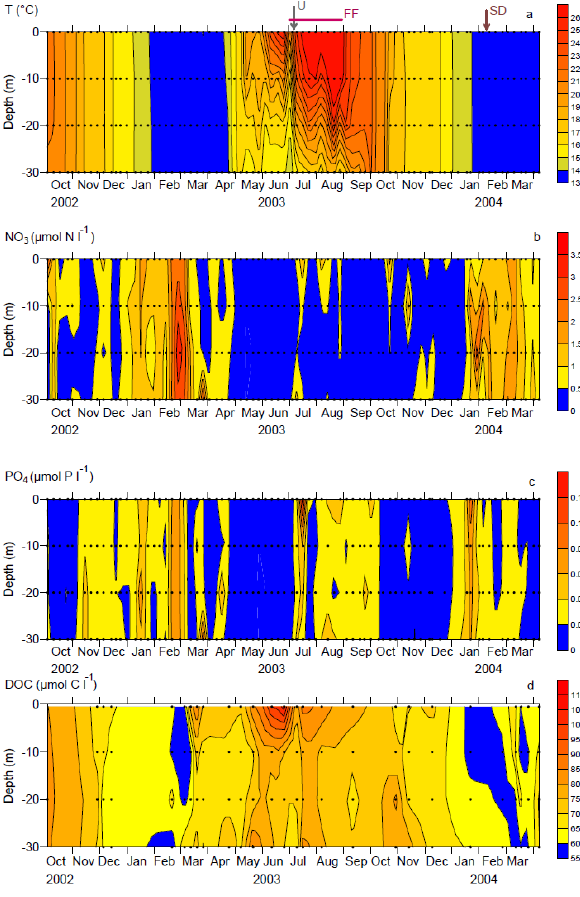
Fig. 2. Physical and chemical characteristics during the study pe- riod for the upper 30m of the water column. Data (except for DOC) were typically collected on a weekly basis. The dots represent sam- pling dates. (a) Temperature ( T ), (b) nitrate (NO 3 ) , (c) phosphate (PO 4 ) and d) dissolved organic carbon (DOC). SD, Sahara dust de- position event, FF, forest fire period; U, upwelling